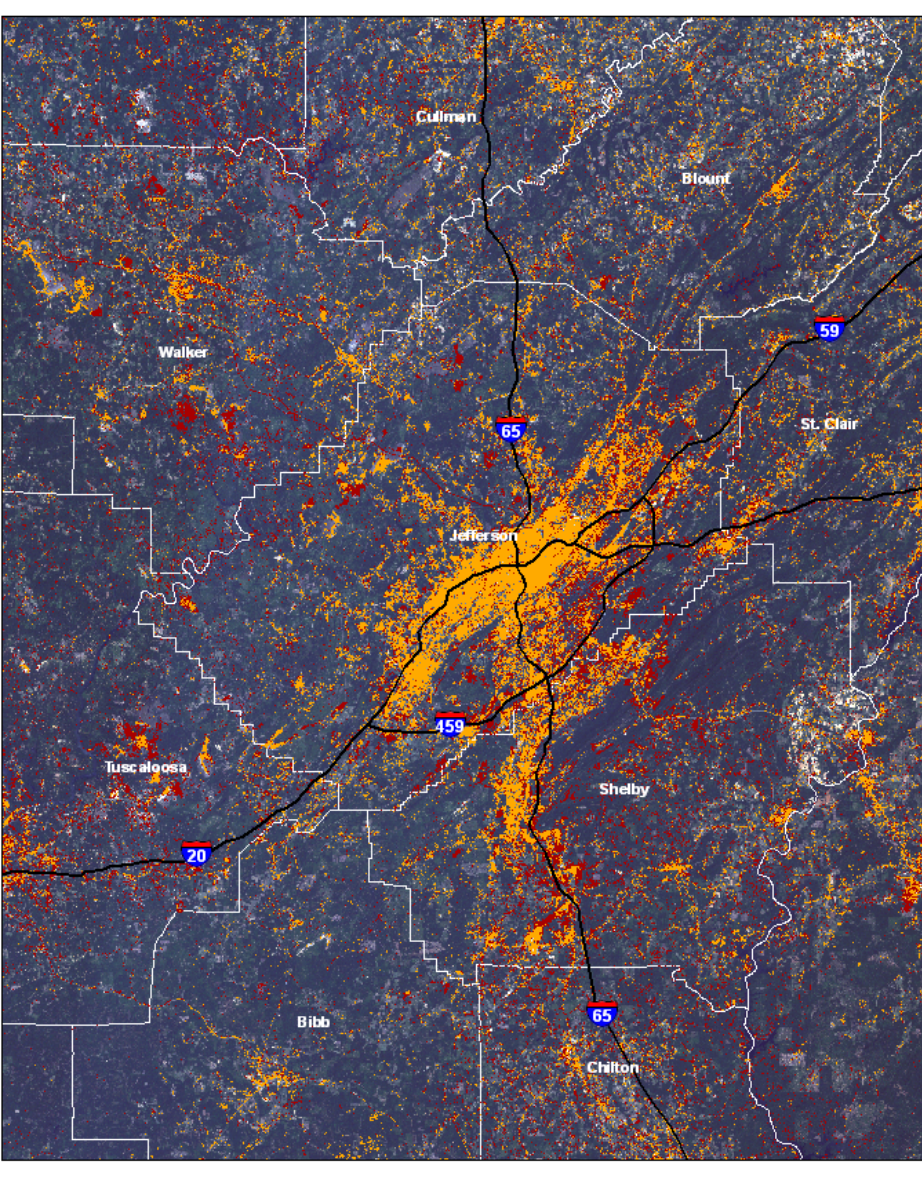
Figure 2. The progression of urbanized land around the city of Birmingham since 1998. Expansion has been greater in southern sections of the city and closely follows major transportation routes in the